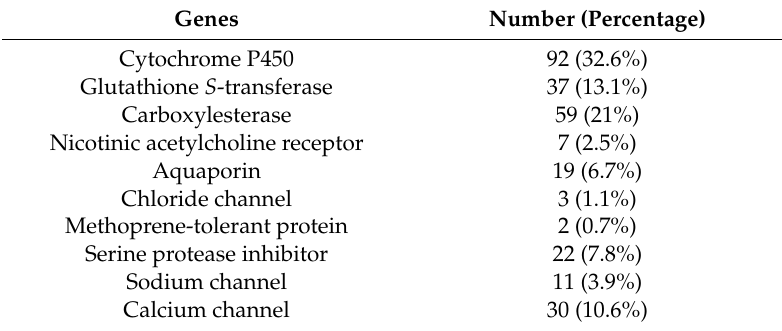
Table 3. Unigenes potentially involved in the detoxification of G. Pyloalis.